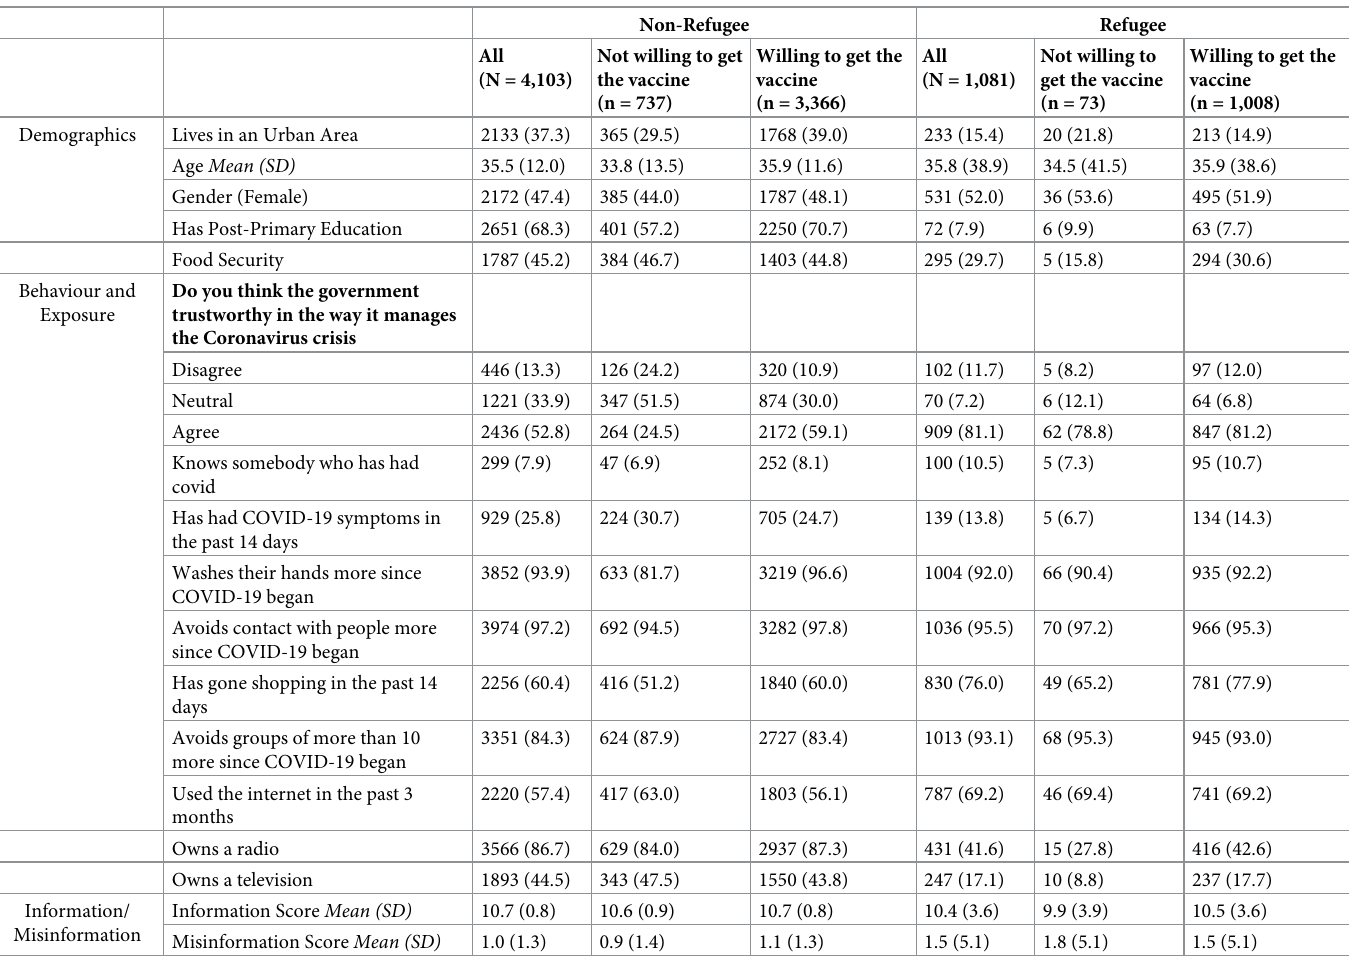
Table 1. Summary table presenting frequencies and rates of key variables, broken down by population and vaccine hesitancy n(weighted %) .